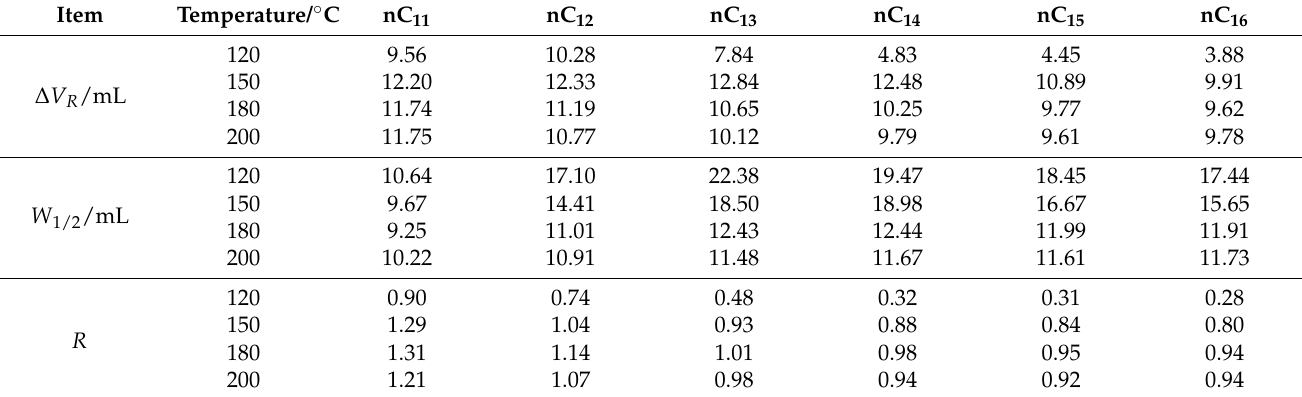
Table 2. Pulse data of nC 11–16 at different adsorption temperatures [36].